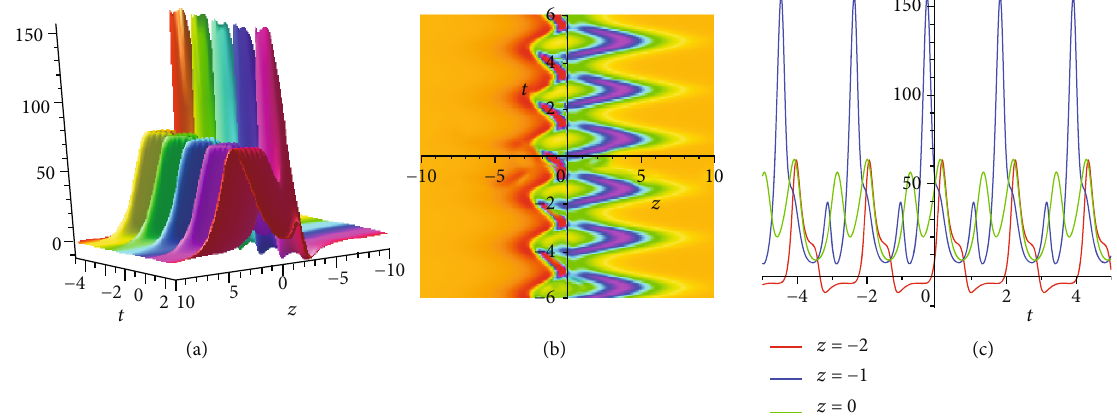
Figure 26: Plots of lump-three kink solutions